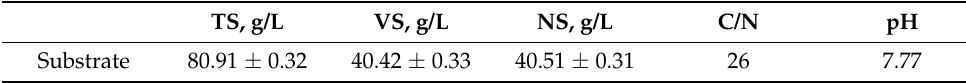
Table 4. Physicochemical parameters of the